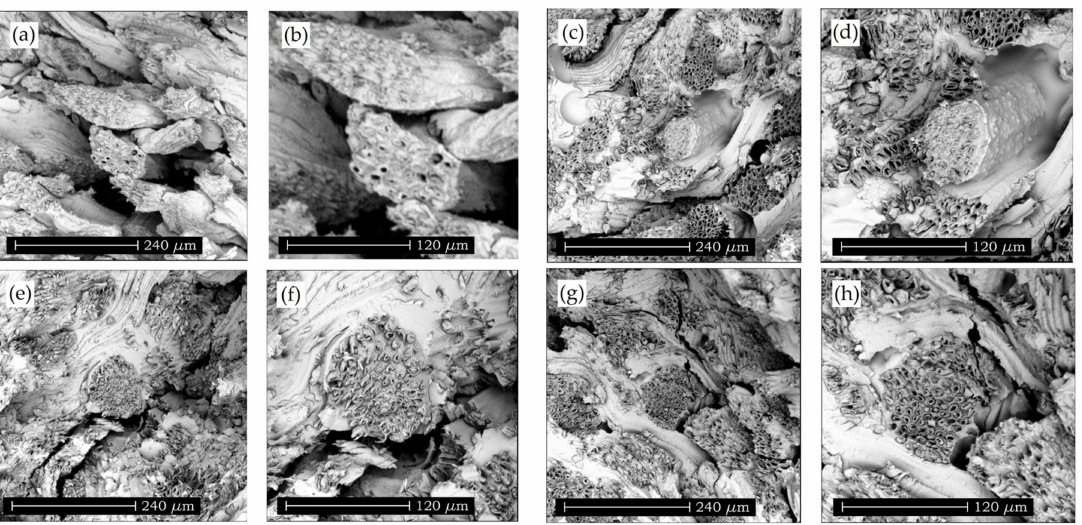
Figure 9. SEM images at different magnifications (a, c, e, g taken at 500 × ; b, d, f, h taken at 1000 × ) of the fractured surface of fibreboards with PO fibres subjected to different chemical treatments, ( a , b ) untreated; ( c , d ) NaOH; ( e , f ) NaOH + APTMS and ( g , h ) NaOH + GLYMO. Black arrows show the improved wetting behaviour between the PO fibres and the surrounding epoxy